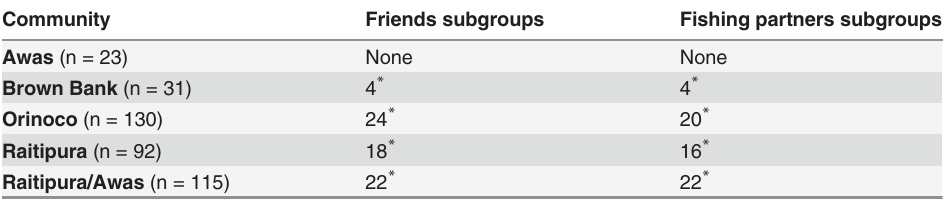
Table 3. Results of KliqueFinder analysis of social network data showing evidence of distinct sub- groups in friends and fishing partners networks in four communities of the Pearl Lagoon basin.